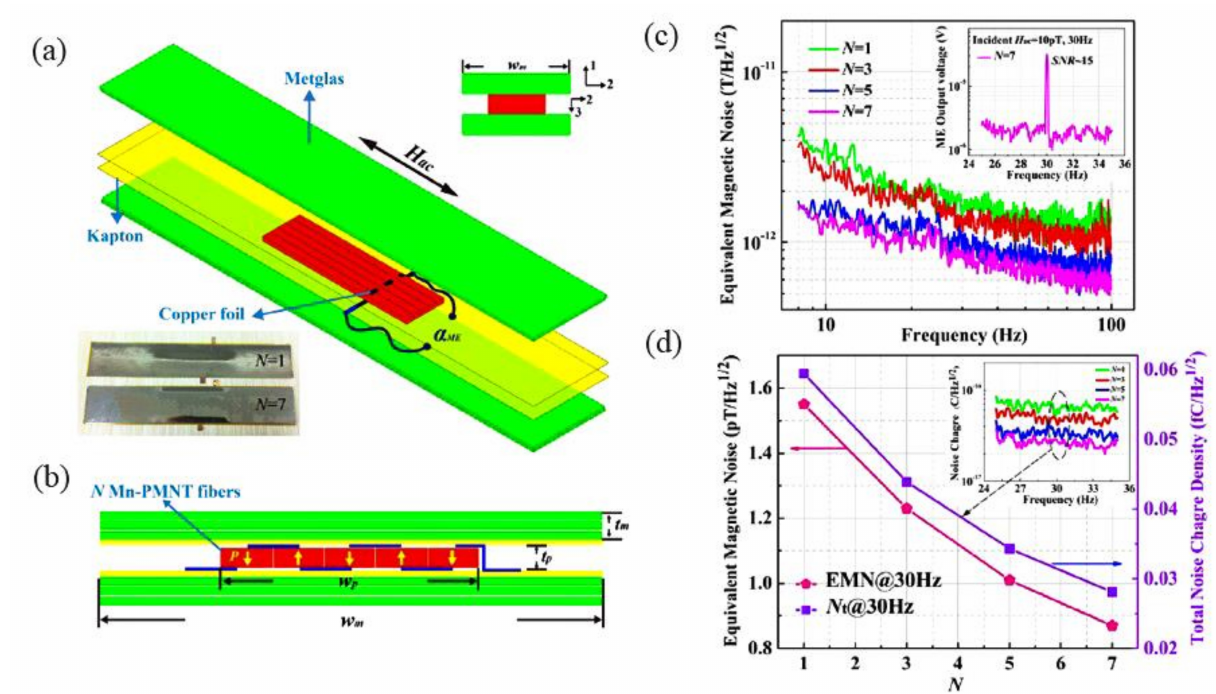
Figure 4. 3D structure of Metglas/Mn-PMNT ME composite ( a ) and its cross-sectional diagram ( b ); ( c ) The EMN over the frequency range of 8 Hz < f < 100 Hz. ( d )The EMN and N t of different Metglas/Mn-PMNT sensors at 30 Hz